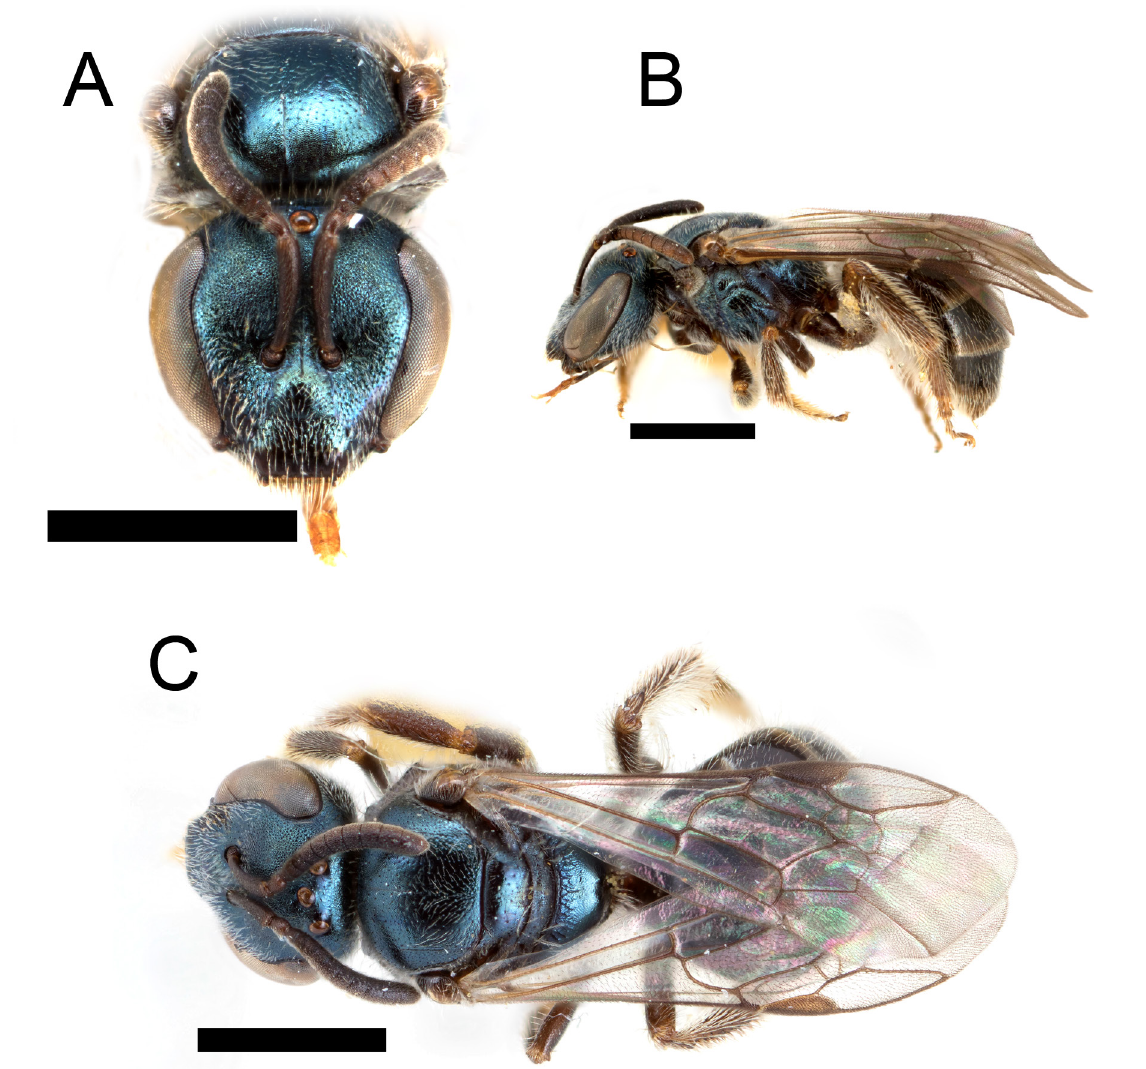
Fig. 21. Lasioglossum gundlachii (Baker, 1906), ♀. A . Face. B . Lateral habitus. C . Dorsal habitus. Scale bars = 1